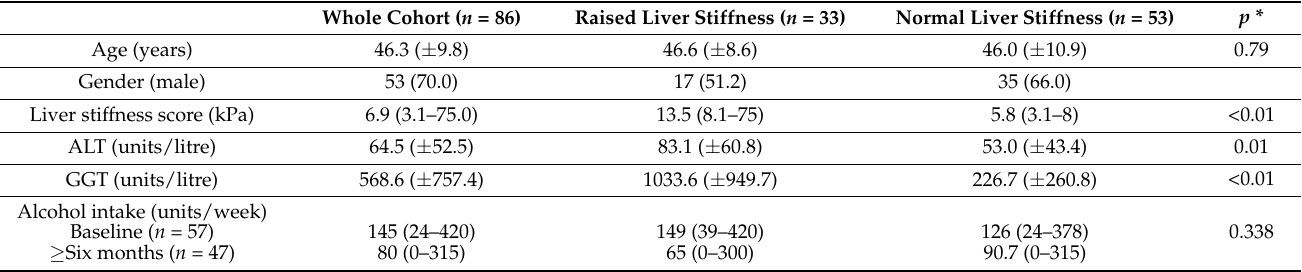
Figure 1. Consort diagram to show participant recruitment. Table 1. Characteristics of included